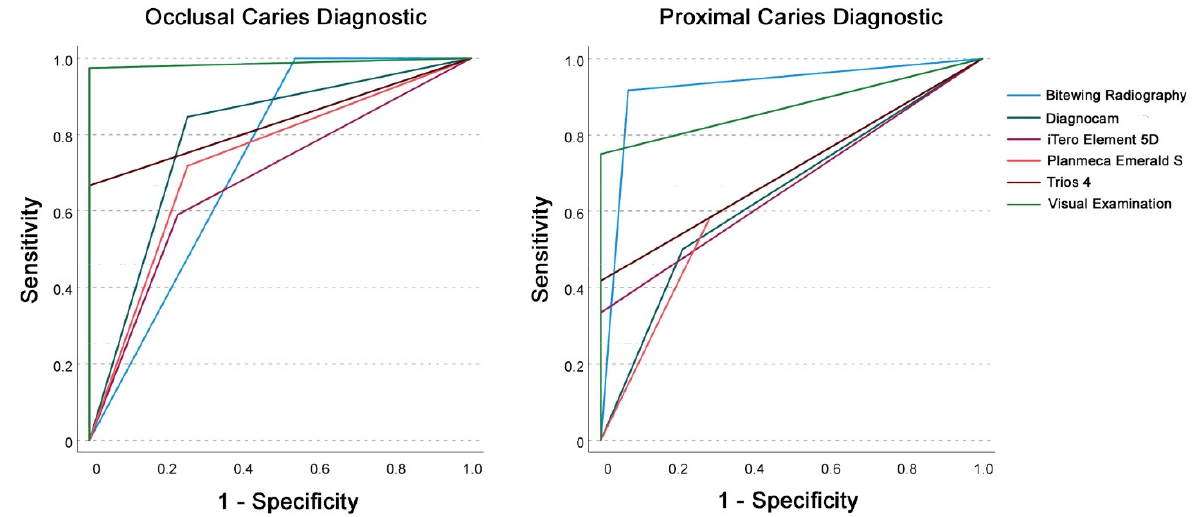
Figure 7. Receiver operating characteristic (ROC) curve analysis for occlusal ( left ) and proximal ( right ) caries diagnostics for the investigated diagnostic methods in primary teeth with threshold II (sound/enamel caries versus dentin caries).